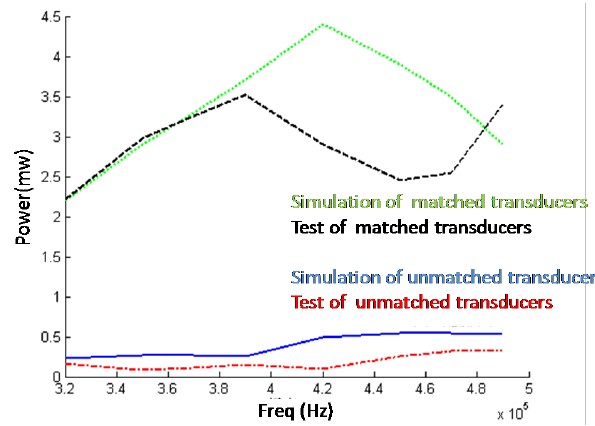
Figure 20. Comparison of experimental results and simulation